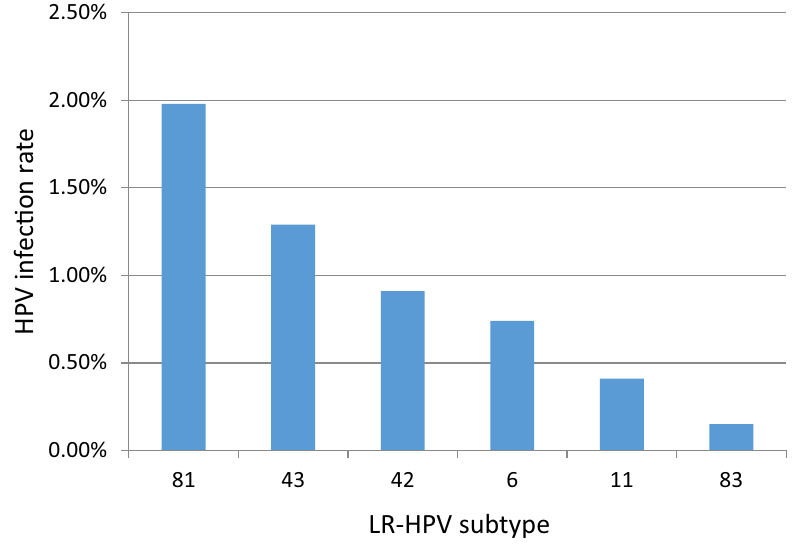
Figure 4. Distribution of LR-HPV subtypes infection.